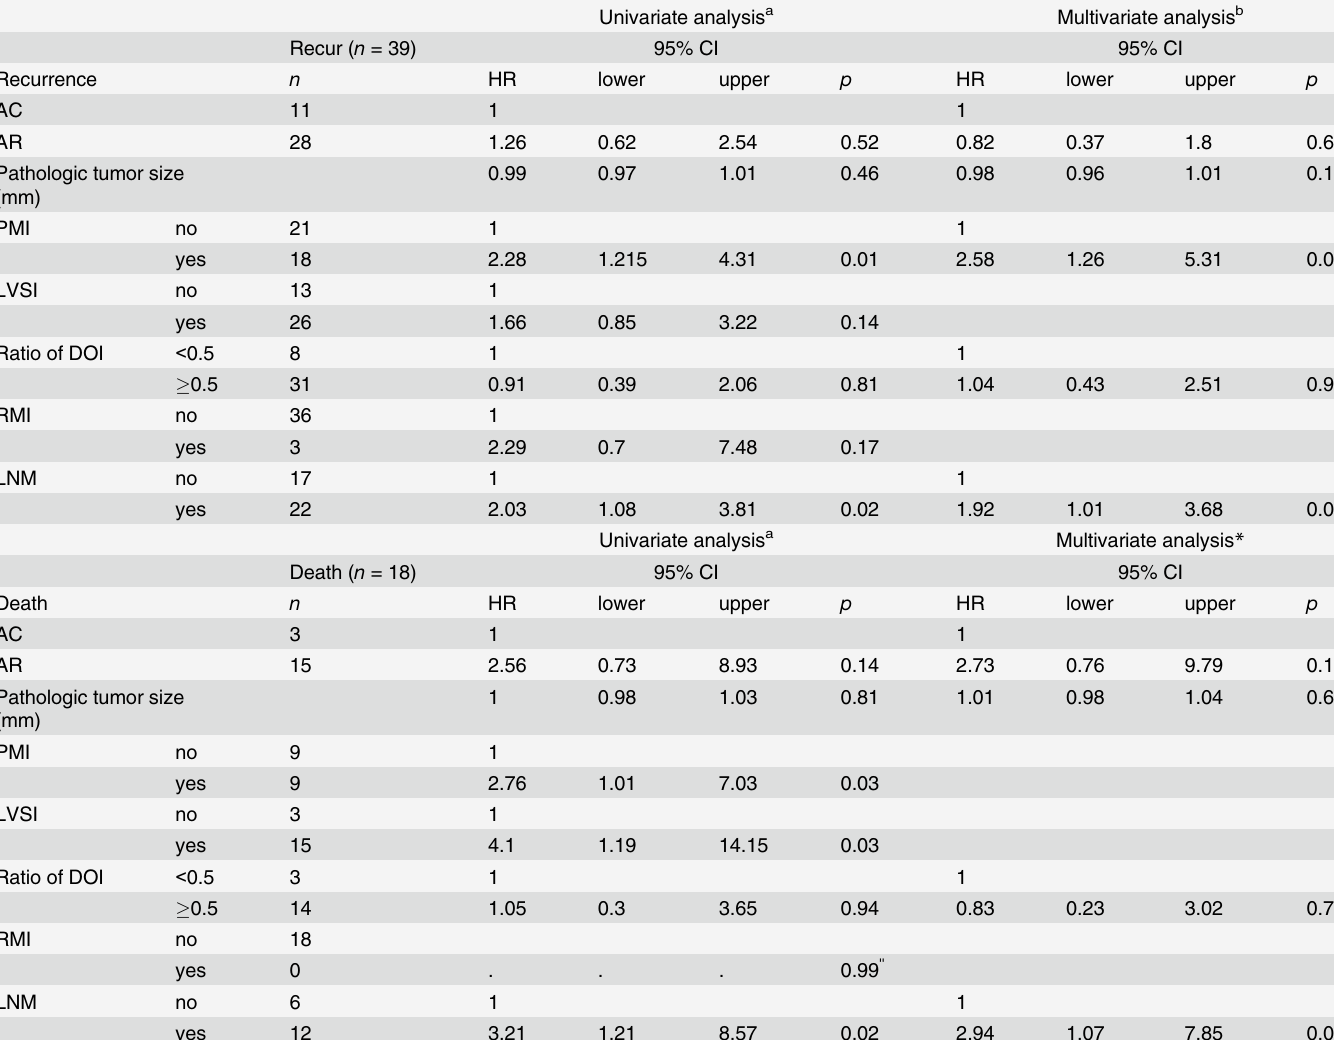
Table 2. Univariate and multivariate analysis of recurrence and death.